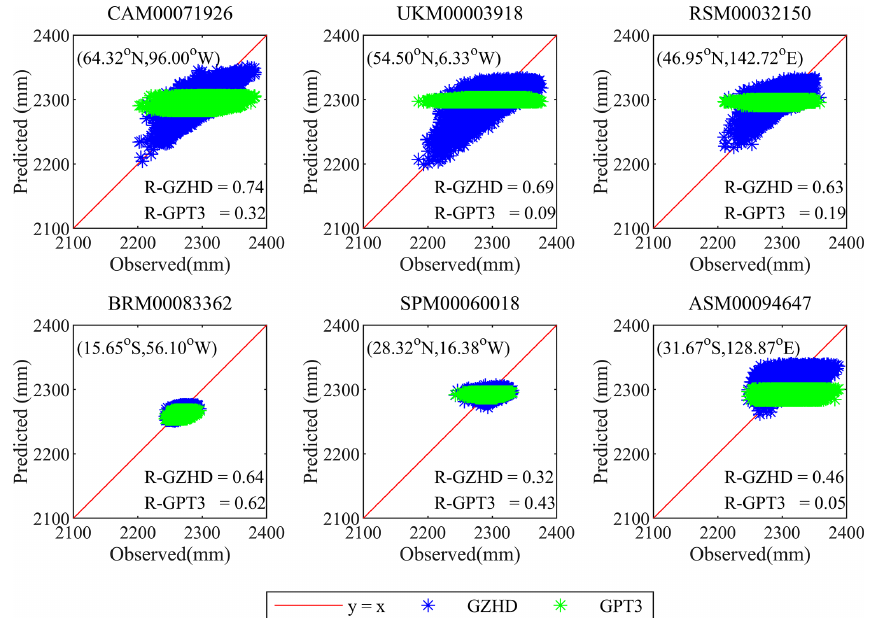
Figure 7. Correlation between the two model-predicted ZHD time series, ZHD-GZHD (blue) and ZHD-GPT3 (green), shown on the vertical axis and ZHD-RS (i.e., observed, on the abscissa axis) at the six radiosonde stations shown in Fig. 6.